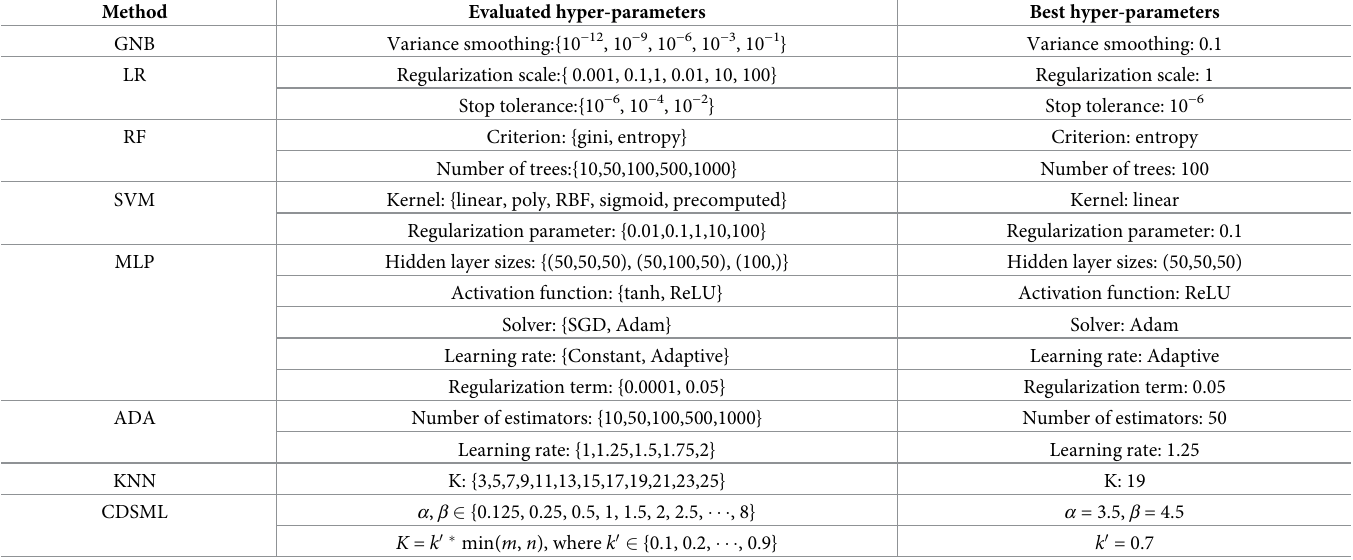
Table 7. The evaluated hyper-parameters and the best values of hyper-parameters for off-the-shelf classification methods. Method Evaluated hyper-parameters Best